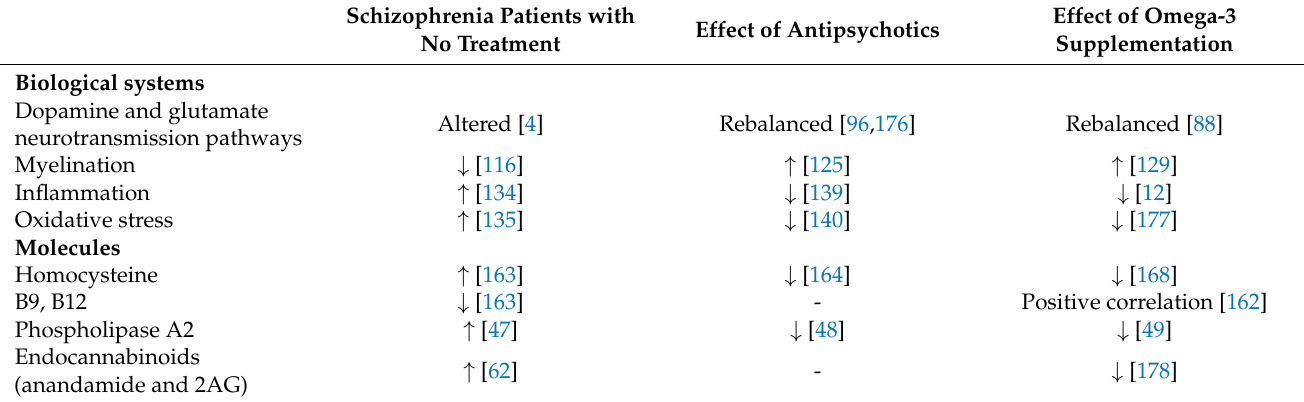
Table 1. The biological effects of antipsychotics and omega-3 supplementation in patients with